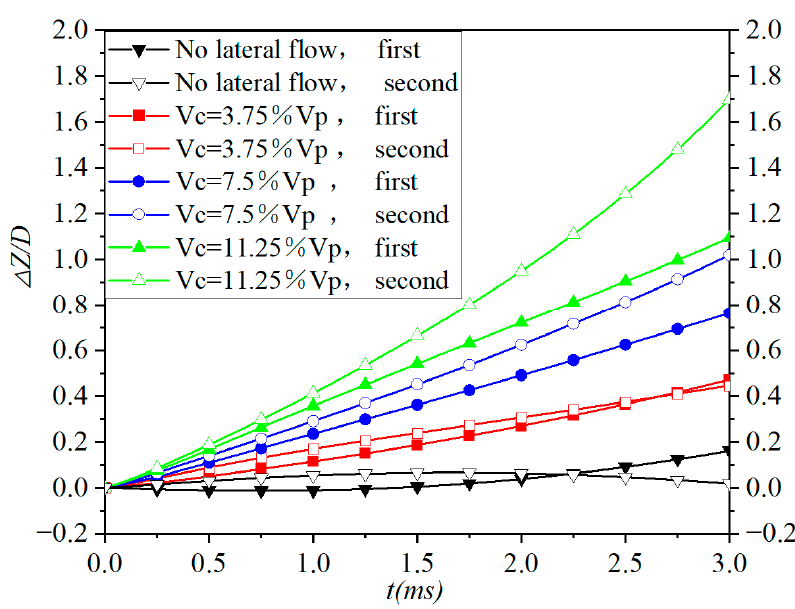
Figure 15. The change in the displacement of the projectiles in the z-direction.